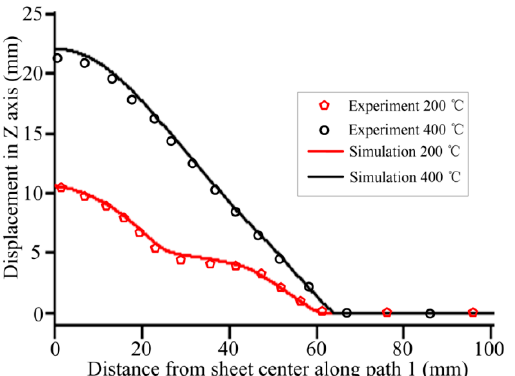
Figure 10. Comparison of simulated and experimental deformed profiles.